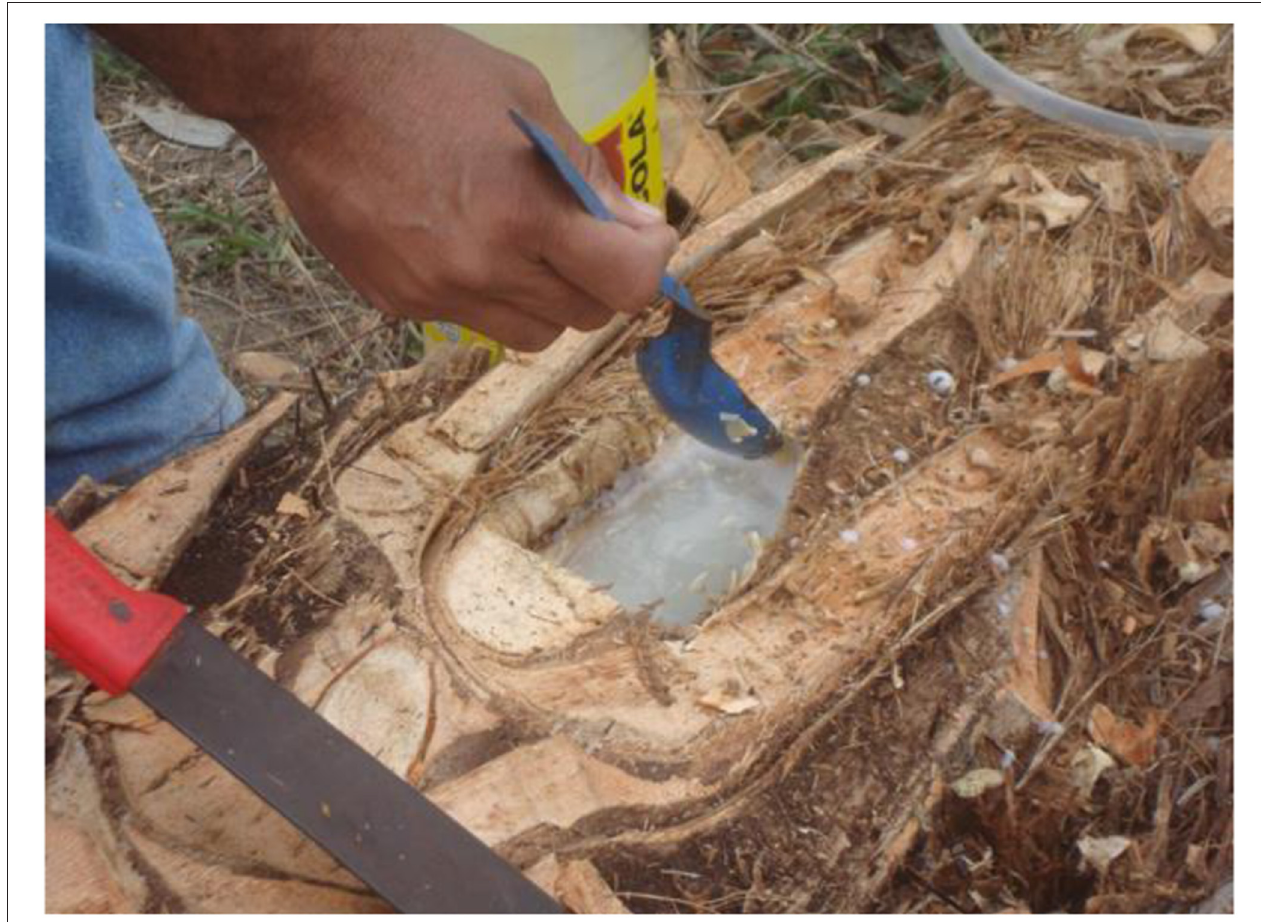
FIGURE 6 | Scraping and cleaning process of the “canoe” after as much sap as possible was